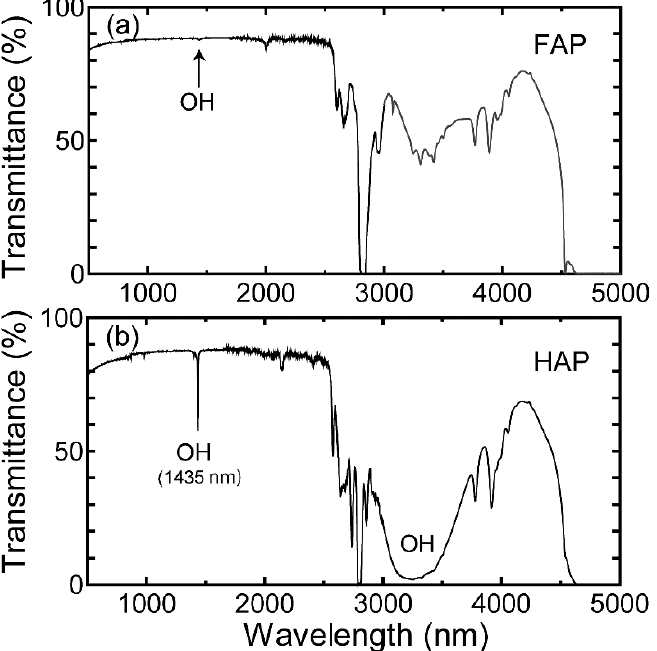
Figure 6. Infrared transmittance spectra of ( a ) FAP and ( b ) HAP ceramics as measured by vis-NIR and FT-IR spectrometry.